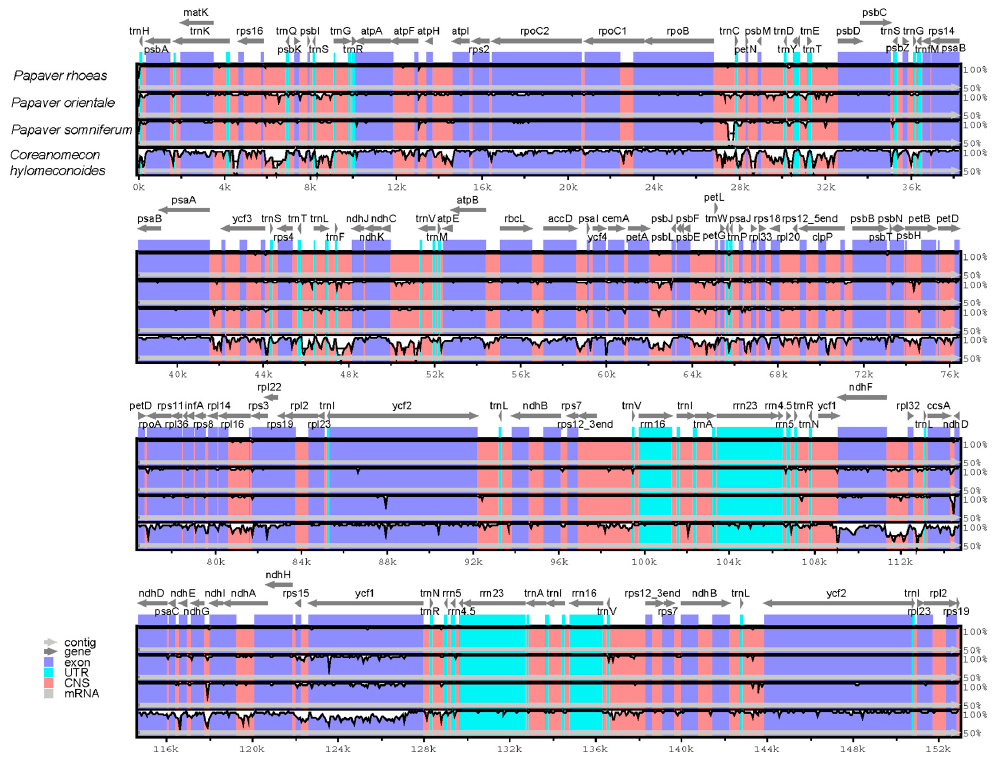
Figure 6. Sequence identity plot comparing the four chloroplast genomes with P. rhoeas as a reference by using mVISTA. Gray arrows and thick black lines above the alignment indicate genes with their orientation and the position of the inverted repeats (IRs), respectively. A cut-off of 70% identity was used for the plots, and the Y-scale represents the percent identity ranging from 50 to 100%.